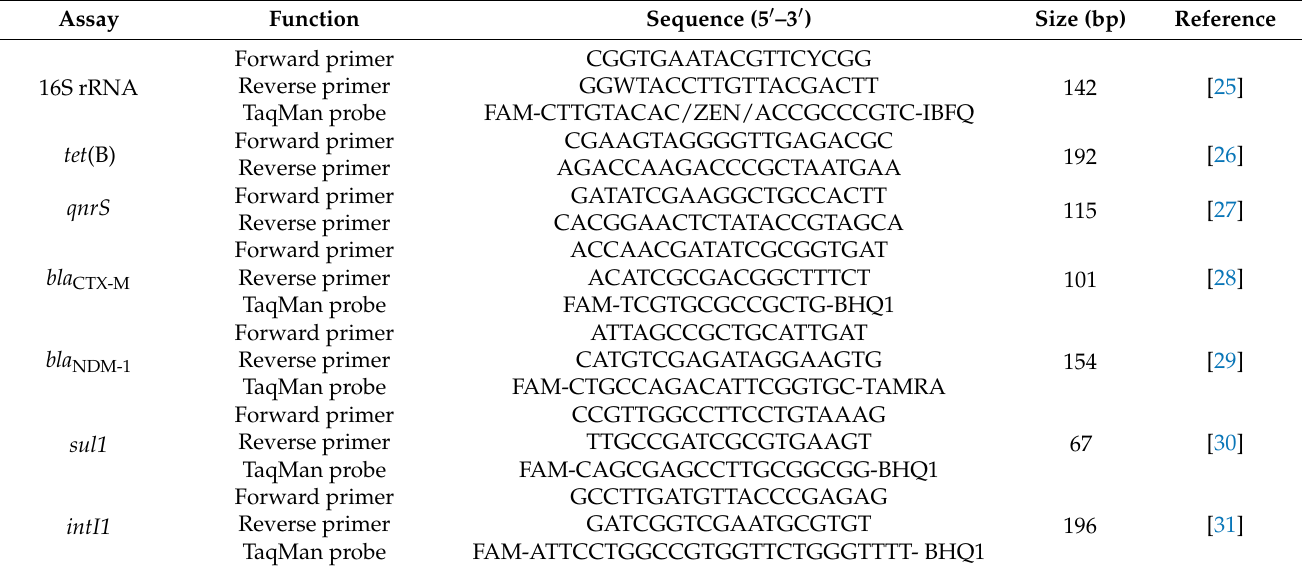
Table 2. Nucleotide sequences of primers and probes used in the